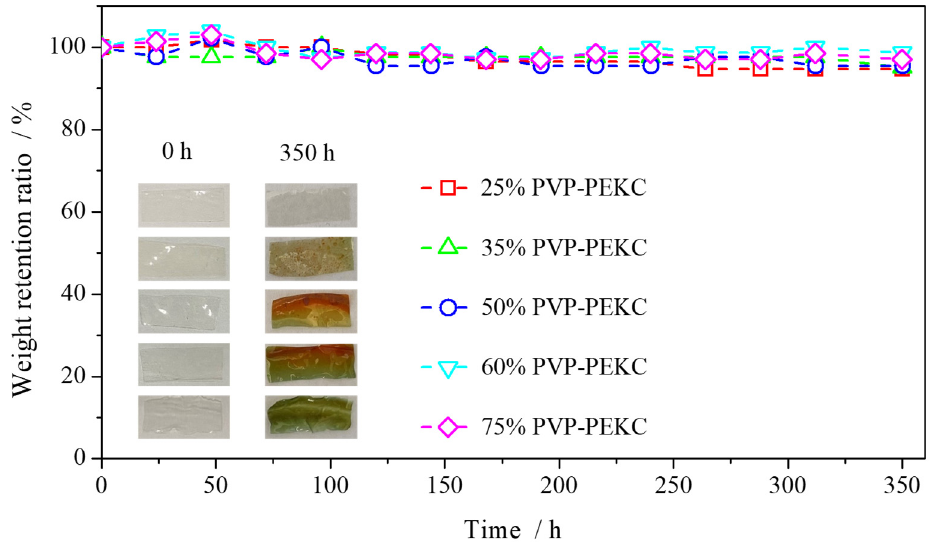
Figure 9 . Weight retention ratio of x%PVP-PEKC membranes during the chemical stability test in 1.5 M VO 2+ solution.